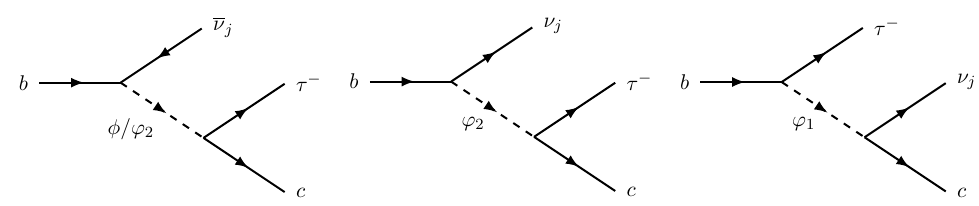
Figure 3. Dominant model contributions to the charged-current b ! c(cid:28)(cid:23) process, not assuming a global conservation of lepton (cid:13)avour, where j 2 f e; (cid:22); (cid:28) g